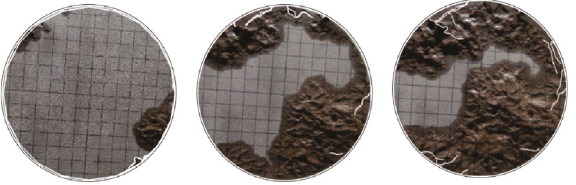
Figure 8: Rapid development stage.